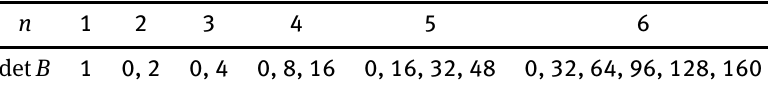
Table 1: Possible absolute values of the determinant of n × n matrices with elements ±1